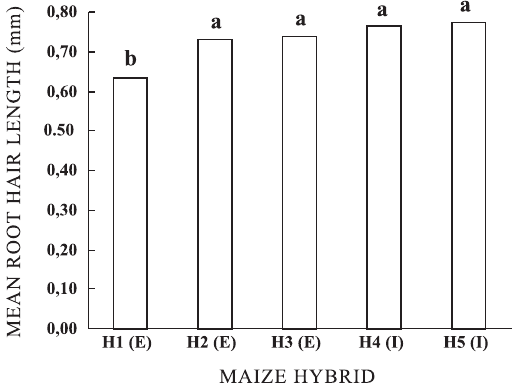
5%.Figure 1. Mean root hair length of maize hybrids contrasting in P-use efficiency. Means followed by the same letter did not differ significantly by the Scott-Knott test, at 5%.